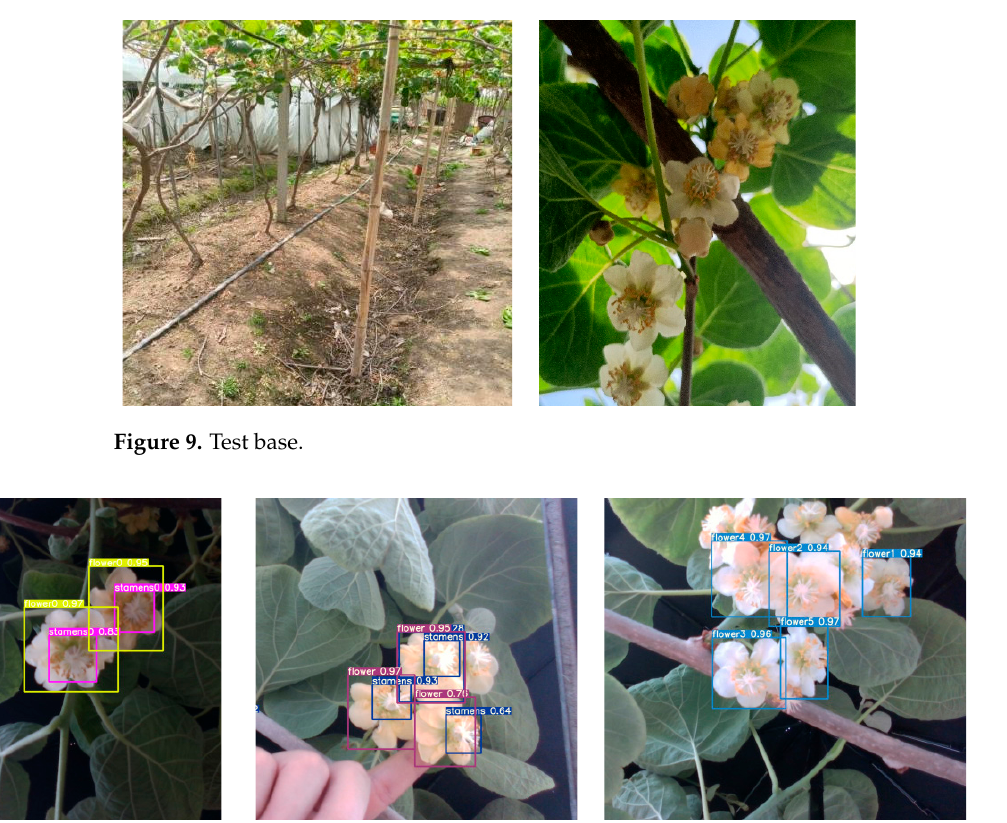
Figure 10. Distribution of fl ower overlap.